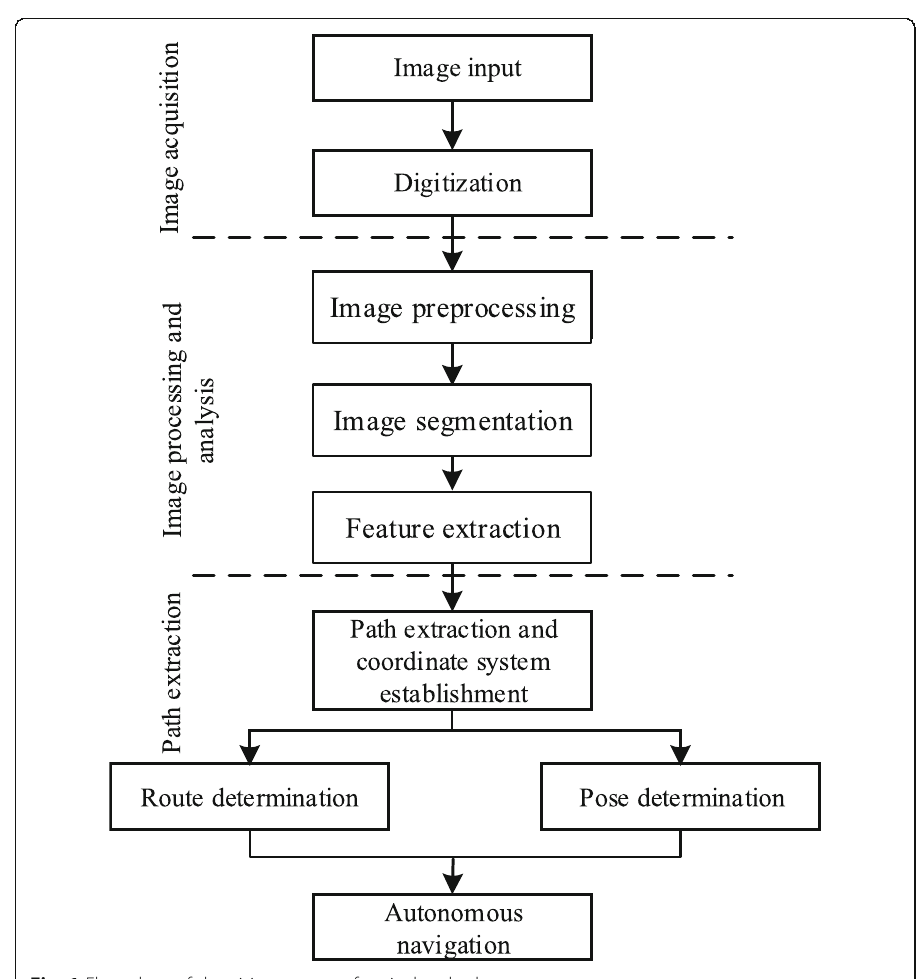
Fig. 1 Flow chart of the vision system of agricultural